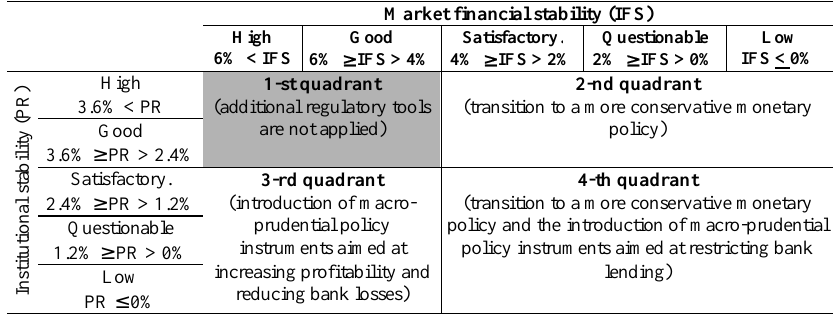
Table 5. Criteria for selecting regulatory tools at the macro level